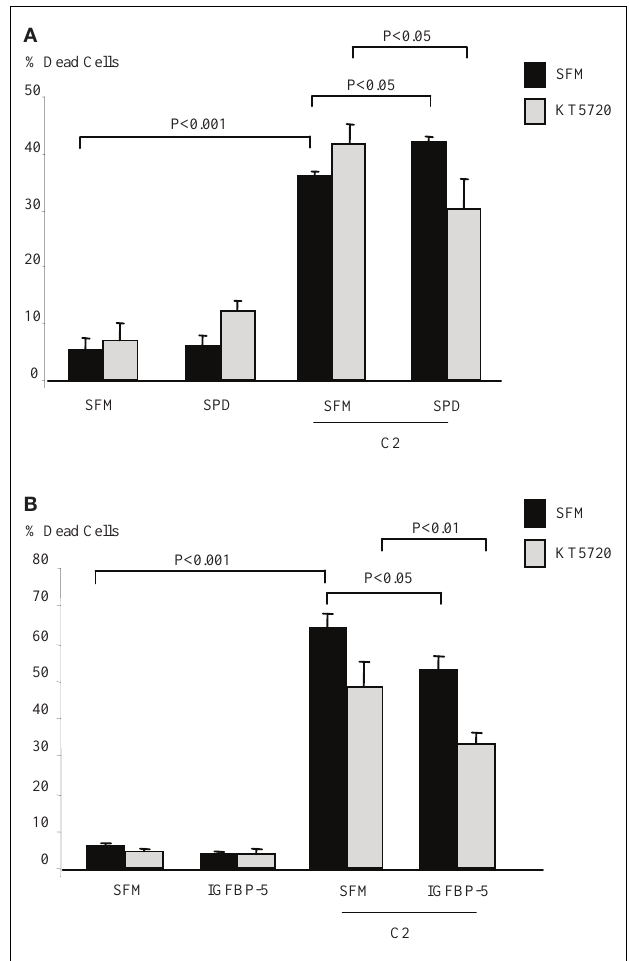
FIGURE 1 | Hs578T cells were seeded in six-well plates at 0.1 × 10 6 cells in GM followed by 24h in SFM prior to pre-dosing (A) with SPD (10ng/ml) or (B) IGFBP-5 ± KT5720 (1 μ M). The cells were then re-dosed with IGFBP-3 or IGFBP-5 (each at 100ng/ml) for a further 24h in the presence or absence of an apoptotic dose of C2-ceramide.The graphs represent changes in cell death and show the mean ± SEM of three experiments each repeated in